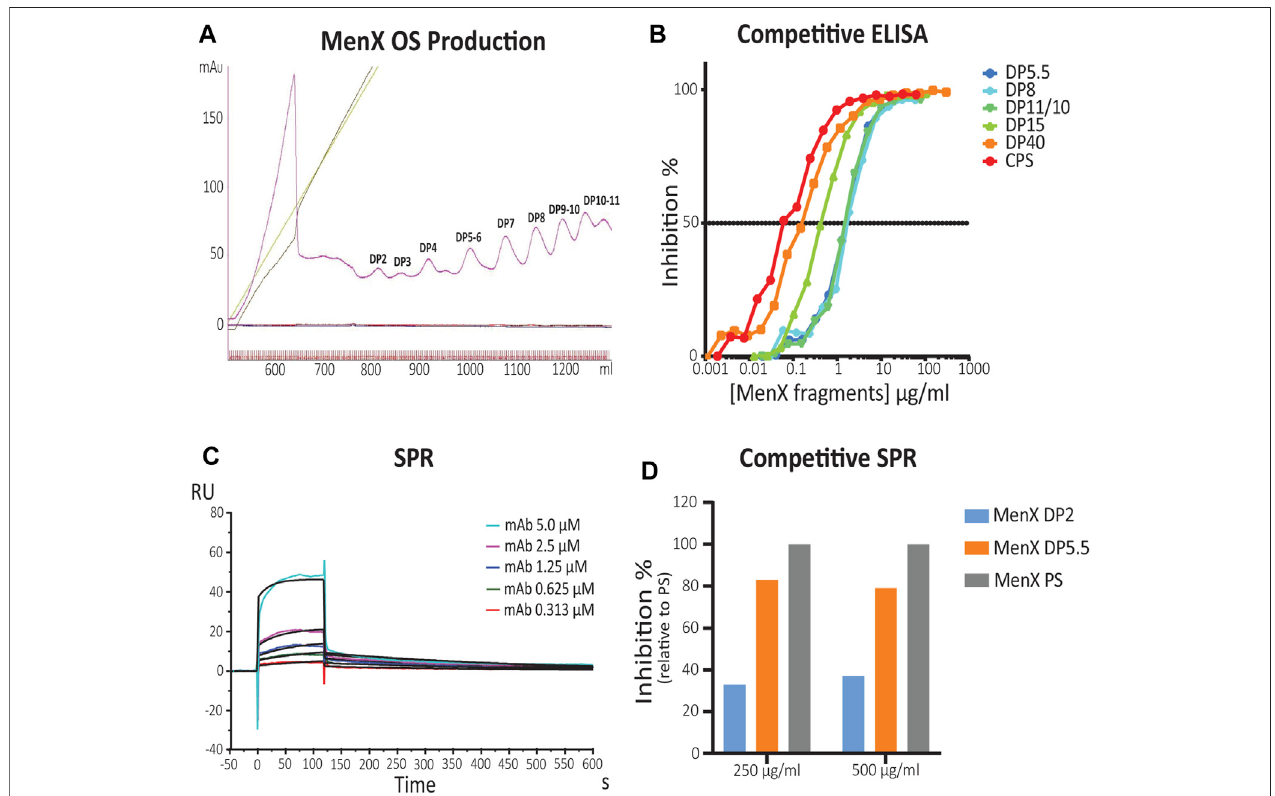
FIGURE 3 | Identi fi cation of the MenX antigenic determinant by competitive ELISA and SPR. (A) Puri fi cation of different length MenX OS fragments. Sepharose Q column chromatography of depolymerized MenX CPS. (B) MenX.01 inhibition ELISA using different length inhibitors. Different MenX fragments were used as inhibitors, and MenXCPS and PFT(PBScontaining1%FCSand 0.05%Tween20) bufferwere usedasthepositiveand negativecontrols, respectively. (C) SPRkineticanalysisof MenX.01.Bindingkineticsandaf fi nityconstantsofMenX.01toMenX-CRM 197 weredeterminedbyserialdilutionsofthetestantibodyMenX.01.mAbwas fl